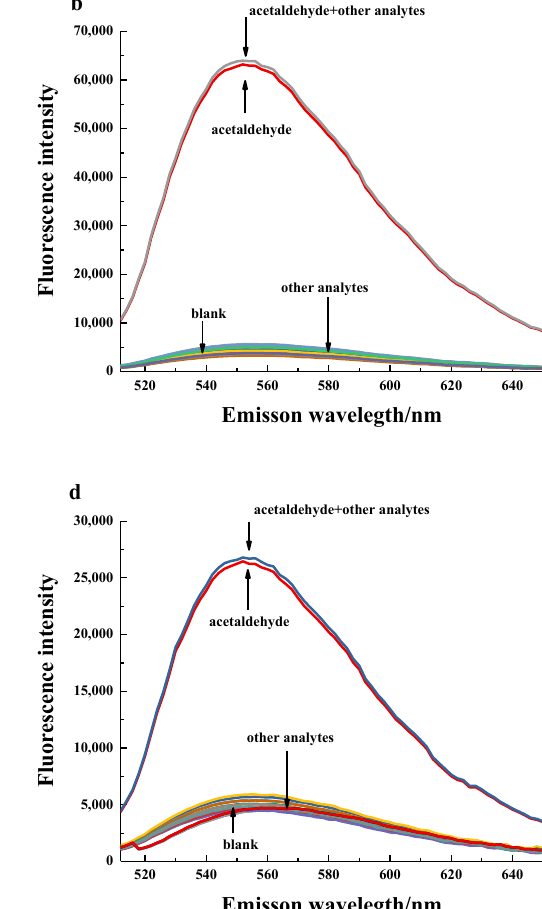
the lowest occupied orbital (LUMO) profiles of FPN1 and FPN1-CH 3 CHO are shown in Figure S6a. The energy ranges between the HOMO and LUMO energy levels of FPN1 and FPN1-CH 3 CHO were 0.11288 ev and 0.09605 ev. Compared with FPN1, the energy gap of FPN1 ‐ CH 3 CHO was relatively low, resulting in a red shift in the fluorescence spectrum. Using time ‐ dependent density functional theory (TD ‐ DFT) theoretical calculations, the HOMO and LUMO of FPN1 ‐ CH 3 CHO at the ground state and excited state were further studied, which is shown in Figure S5b. The maximum absorption peaks are 482 nm (f = 0.3502) and 583 nm (f = 0.3598), which is consistent with the actual detection results. There ‐ fore, all results indicate that PET is inhibited and the nucleophile substitution reaction occurs.